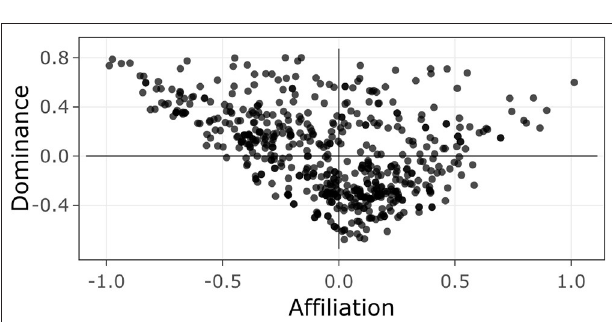
FIGURE 4 | Distribution of neutral faces in computed dominance (y) and affiliation (x) social face space.